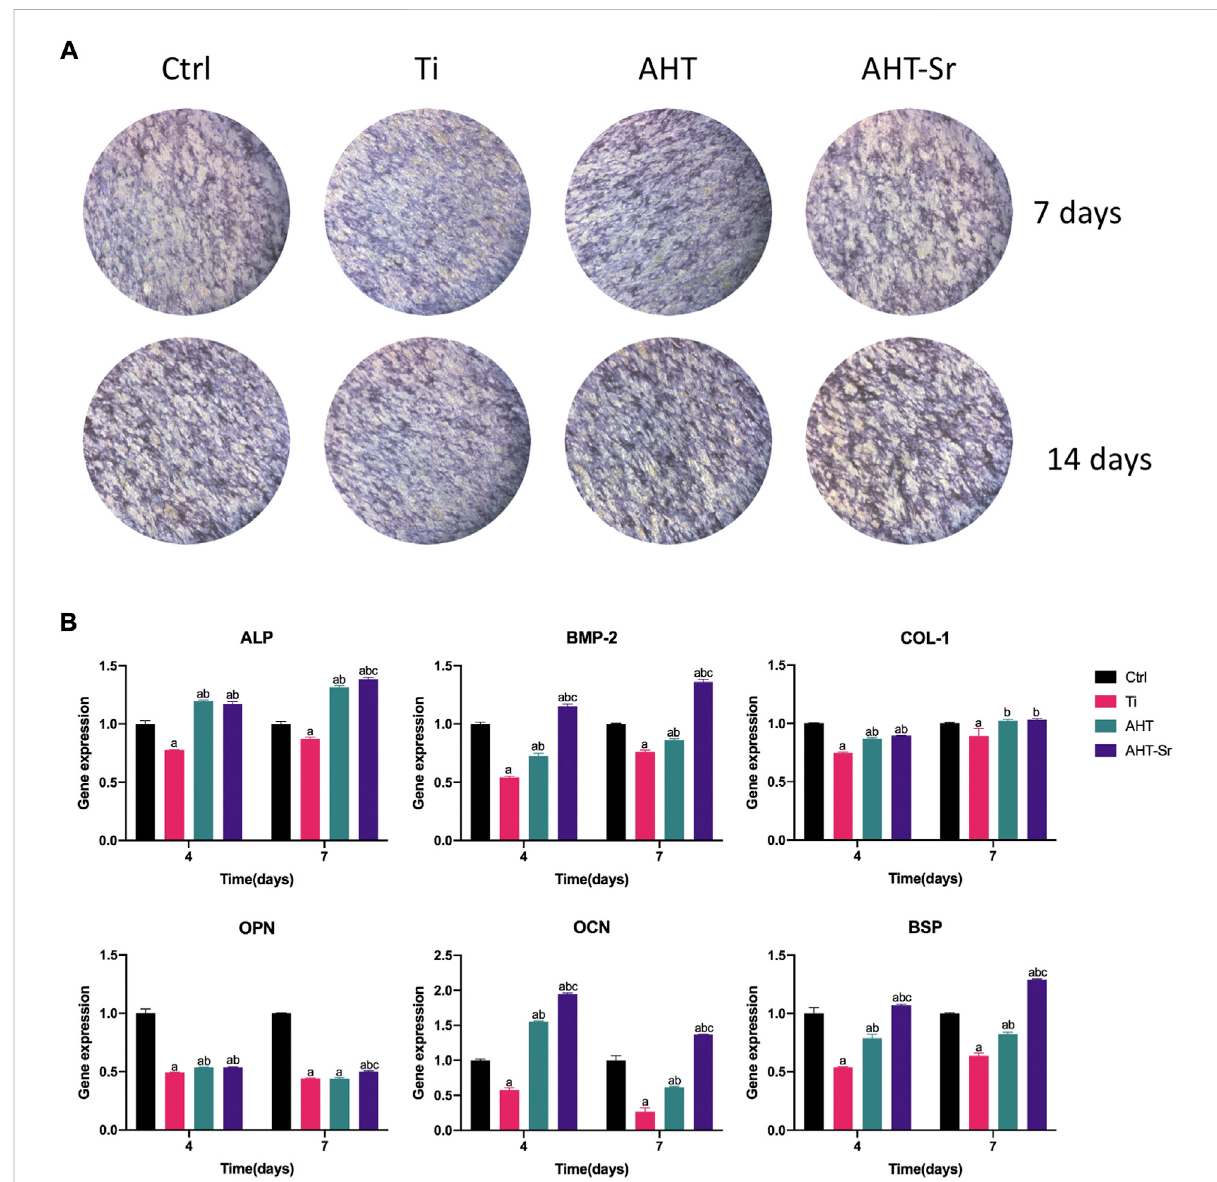
FIGURE 5 AHT-Sr promoted osteogenic differentiation of OVX-BMSCs. (A) ALP staining of H-BMSCs and OVX-BMSCs cultured on Ti, AHT and AHT-Sr disks for 4 and 7 days. Representative images of three separate experiments. (B) mRNA expression of selected osteogenic markers in H-BMSCs and OVX-BMSCs that were cultured on different Ti disks for 4 and 7 days. Error bars indicate the SD of three separate experiment. * p <